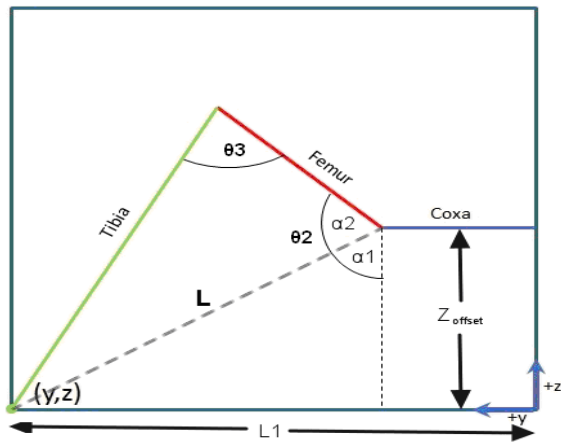
Fig. 6. Quadruped robot one leg side view showing links (Coxa, Femur, Tibia) and